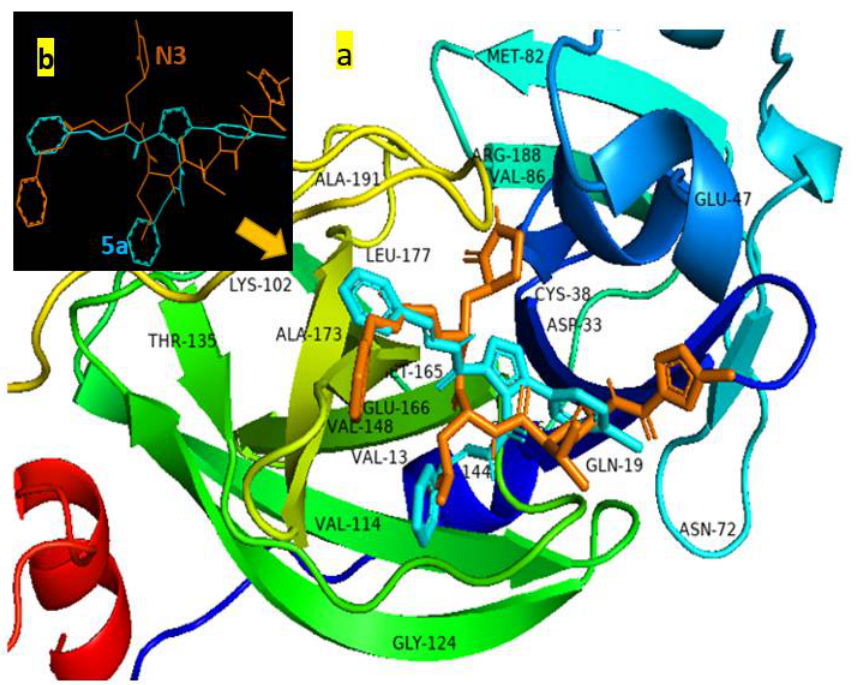
Figure 5. ( a ) The superposition of N3 (orange stick) and compound 5a (cyan stick) docked into the binding pocket of 7BQY represented by PyMOL [42]; ( b )the superposition of N3 (orange stick) and compound 5a (cyan stick), where 7BQY is omitted for clarity.